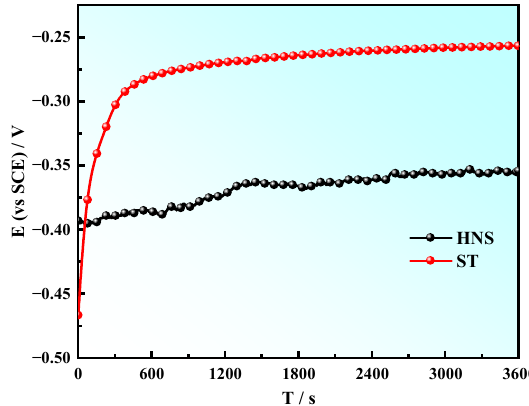
Figure 3. OCP responses of HNS and ST in 3.5% NaCl solution.